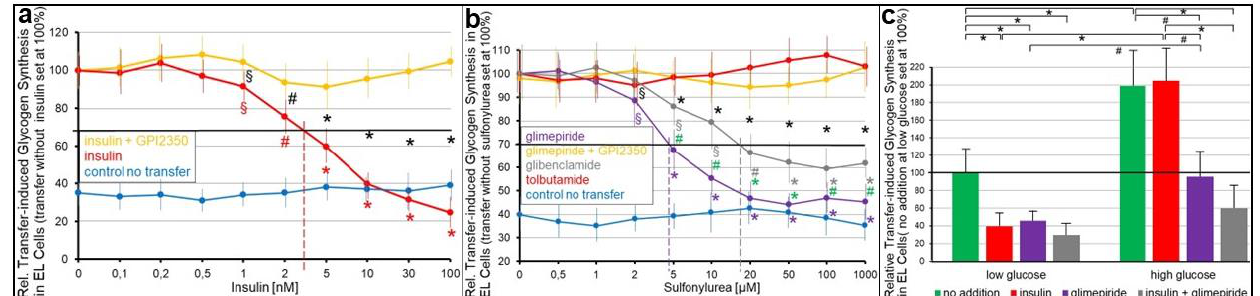
Figure 4. Inhibition of transfer-induced glycogen synthesis in ELCs by insulin and antidiabetic SUs. Transwell co-cultures were run with human donor adipocytes (of lipid-loading stage II) or only medium (( a , b ); control no transfer) and GPI-deficient EL acceptor cells in the insert and bottom wells, respectively, as described in Section 4. After incubation (1 week, 37 °C) in the absence or presence of increasing concentrations of human insulin ( a ) or glimepiride, glibenclamide and tolbutamide ( b ) without or with GPI- PLC inhibitor GPI2350 at 100 μM ( a , b ) or ( c ) in the presence of low (0.1 mM) or high (5 mM) glucose without or with insulin (30 nM) or glimepiride (20 μM) or insulin together with glimepiride as indicated, the ELCs in the bottom plate were assayed for glycogen synthesis (15 min, 37 °C, presence of BSA, 0.1 mM [U- 14 C]glucose) as described in Section 4. The experiments were repeated four to six times (distinct co-cultures) with the determination of glycogen synthesis in triplicate. The relative transfer-induced glycogen synthesis in ELCs is given, with the absence of insulin ( a ), SUs ( b ) or both insulin and glimepiride at low glucose ( c ) set at 100%. Significant differences between the absence and presence of insulin ( a ) or SUs ( b ) at the various concentrations each are indicated with correspondingly colored symbols. Significant differences between the absence and presence of GPI2350 for incubations at each concentration of insulin ( a ) or glimepiride ( b ) and between glimepiride and glibenclamide at each concentration ( b ) are indicated with black and green symbols, respectively. ( c ) Significant differences between the various incubations at either low (left panel) or high glucose (right panel), as well as between low and high glucose in the absence or presence of insulin or glimepiride, are indicated (means ± SD; * p ≤ 0.01, # p ≤ 0.02, § p ≤ 0.05).